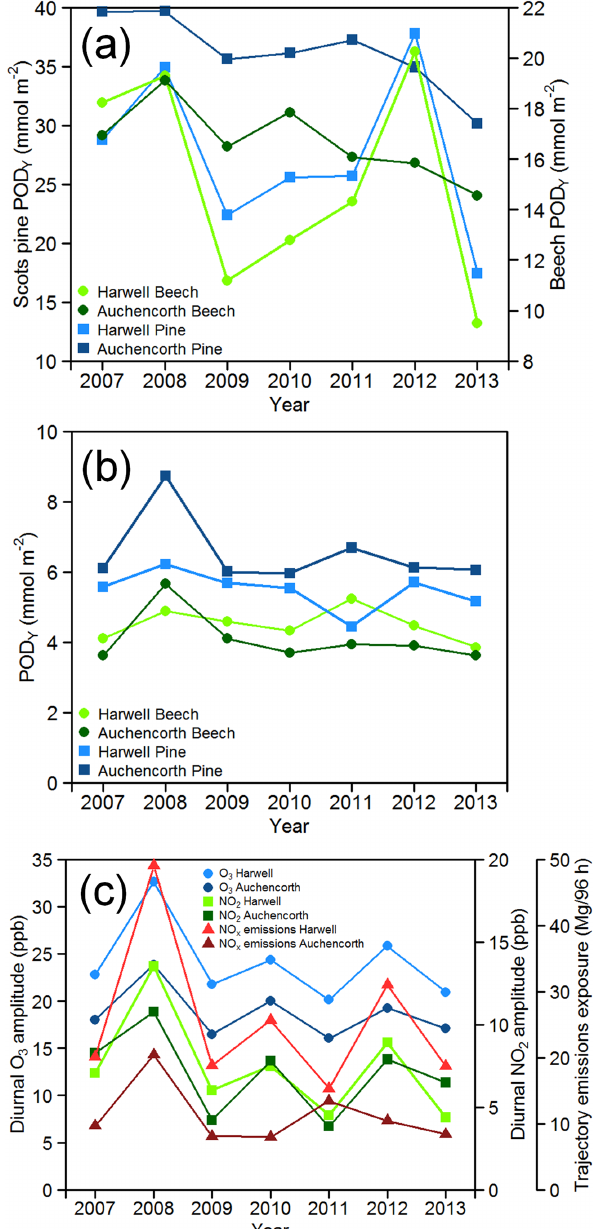
Figure 13. Comparison of O 3 vegetation-impact chemical climates for beech and Scots pine 2007–2013 at Harwell and Auchencorth: (a) annual POD Y for beech and Scots pine; (b) POD Y accumulated in May for beech and Scots pine; (c) May monthly average diur- nal amplitude of O 3 and NO 2 and back-trajectory NO x emission